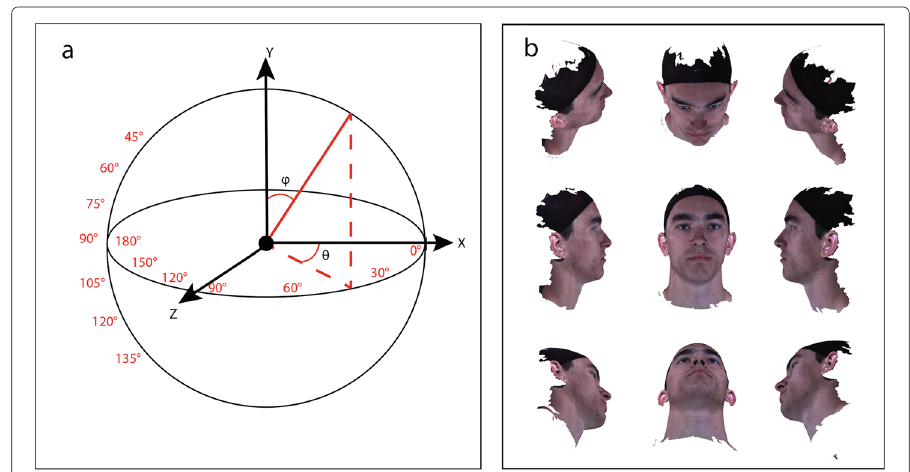
Fig. 3 Camera positions. a Right-handed system spherical coordinates. φ is the polar angle and θ is the azimuthal angle. b Samples for real face images taken from different viewing